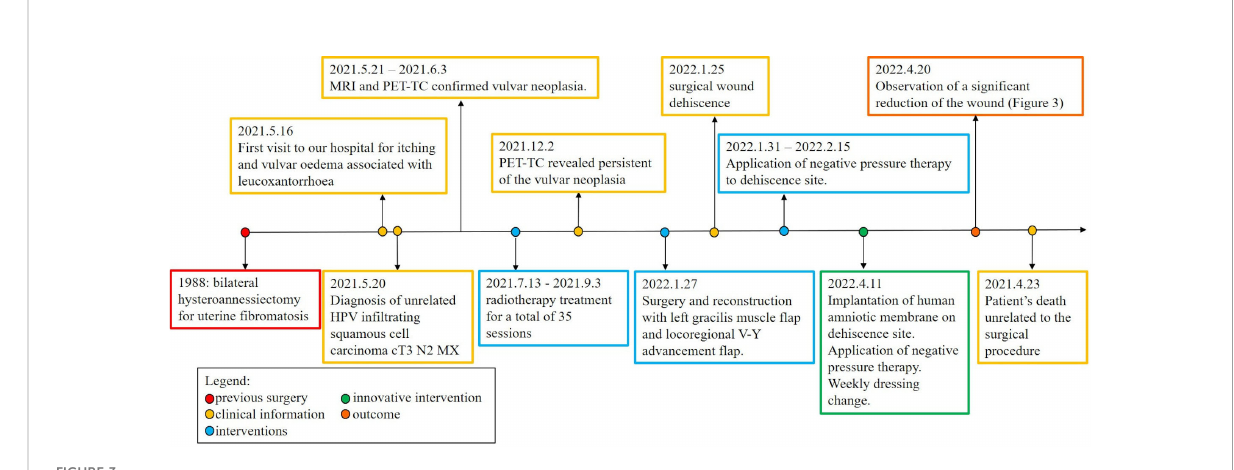
FIGURE 3 Timeline of the clinical